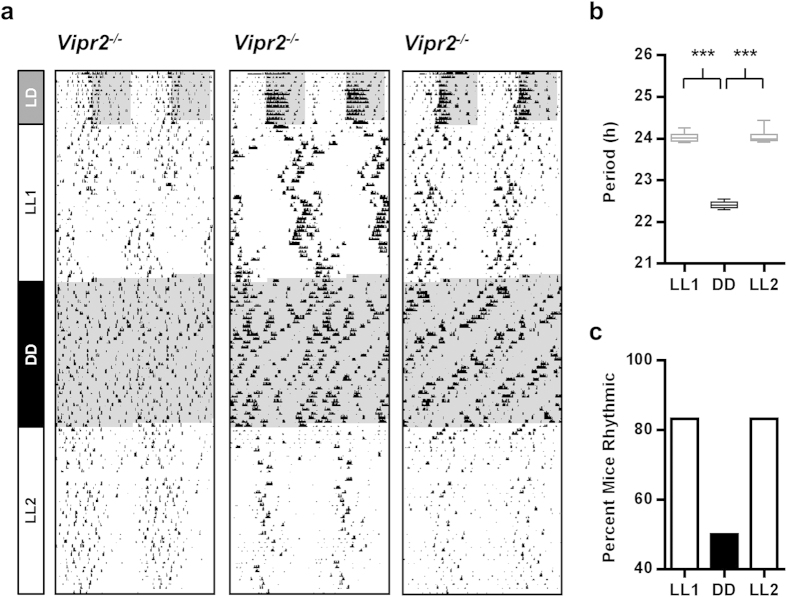
LL-induced improvement in circadian behavior of Vipr2−/− mice depends on continued exposure to LL.Actograms showing wheel-running behavior of Vipr2−/− mice housed under LL conditions for 36 days, then transferred into DD for 36 days, before a second 36 day exposure to LL (a). On transfer to DD, rhythmic Vipr2−/− mice do not sustain the ~24 h rhythms expressed in LL and instead become arrhythmic or show shorter period (~22.4 h) rhythms in wheel-running (also see 24). When subsequently re-exposed to LL, Vipr2−/− mice rapidly alter wheel-running to once again show overt rhythmicity and the characteristic longer period (~24 h) expressed in LL. Actogram plotting and shading as in Fig. 1. Panels (b,c) show a box and whisker plot of period and histogram of rhythmicity, respectively, for LL1, DD and LL2, assessed over the last 12 days of each epoch. Whiskers indicate the maximum and minimum range of period data points. ***p < 0.001.